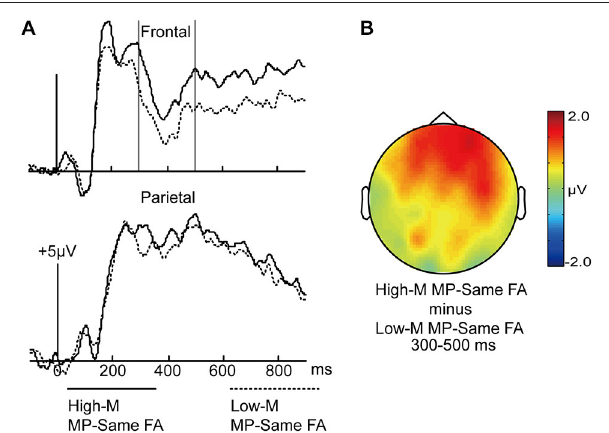
FIGURE 6 | ERPs for High-M MP-same false alarms and Low-M MP-same false alarms trials. (A) Waveforms are shown at frontal and parietal electrodes. Gray vertical lines indicate the significant time window (300–500 ms). (B) A topographical plot depicts ERP differences between High-M MP-same false alarms and Low-M MP-same false